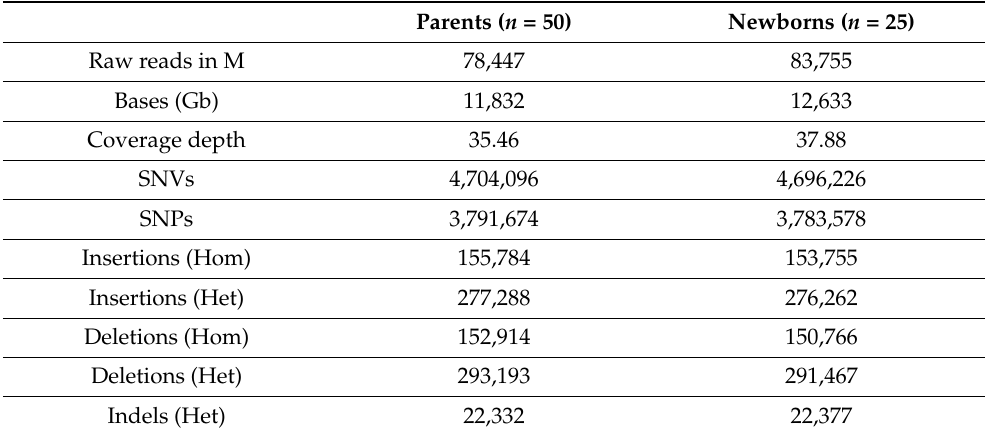
Table 1. The average number of autosomal single nucleotide genetic variants per genome identified in the Lithuanian